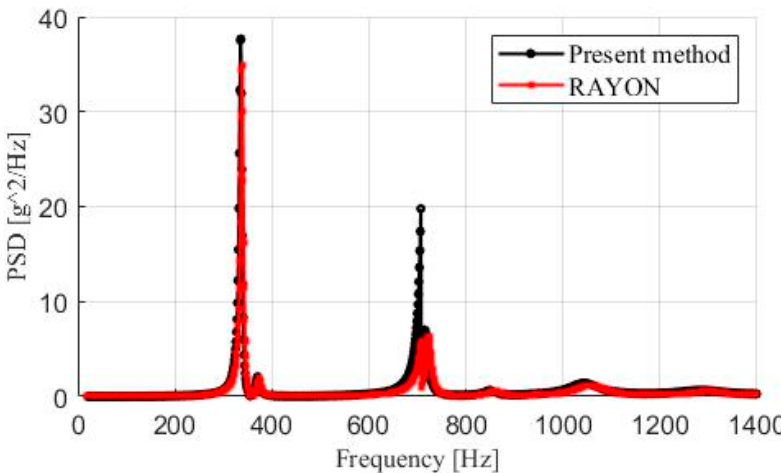
Figure 12. Power spectral density at node P1X (0.0, 0.386) for rectangular plate immersed in diffuse field.